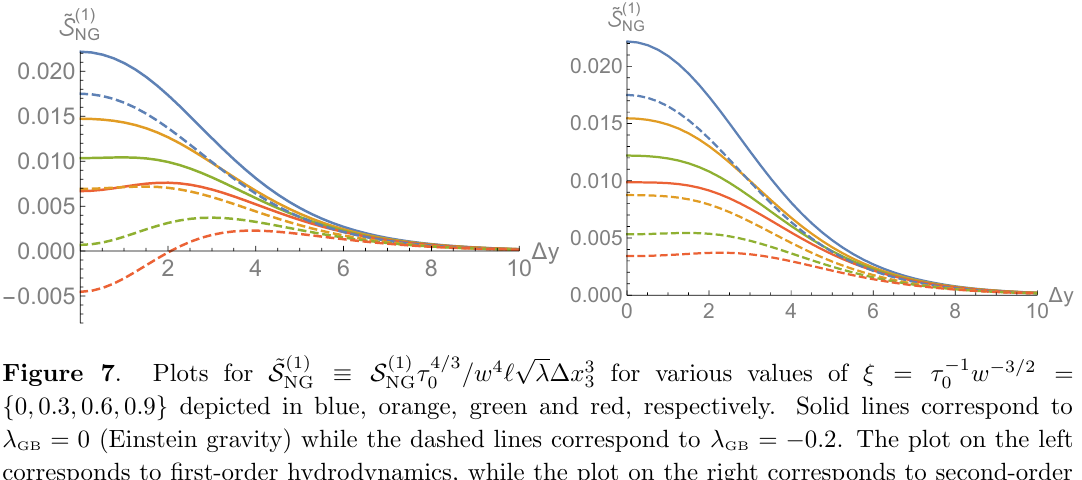
Figure 6 . Plots for ~ S (1) f 0 ; 0 : 3 ; 0 : 6 ; 0 : 9 g depicted in blue, orange, green and red, respectively. Solid lines correspond to (cid:13) = 0 (Einstein gravity) while the dashed lines correspond to (cid:13) = 10 (cid:0) 3 ( (cid:11) 0 -corrections). The plot on the left corresponds to (cid:12)rst-order hydrodynamics, while the plot on the right corresponds to second-order hydrodynamics.